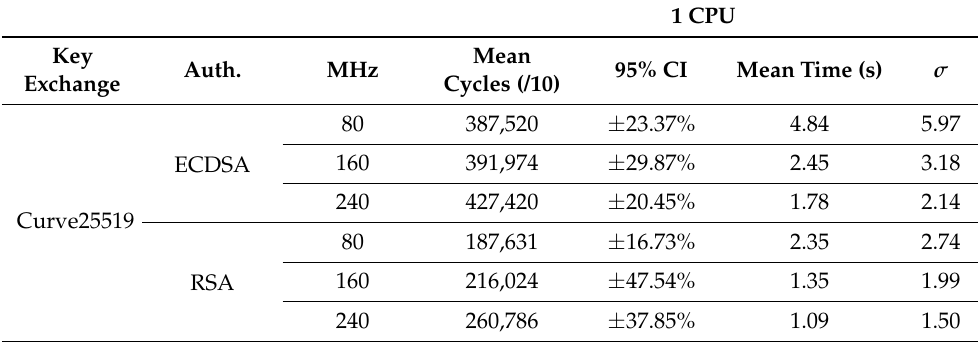
Table 1. Accuracy when network delay is considered. Confidence interval above 16%.